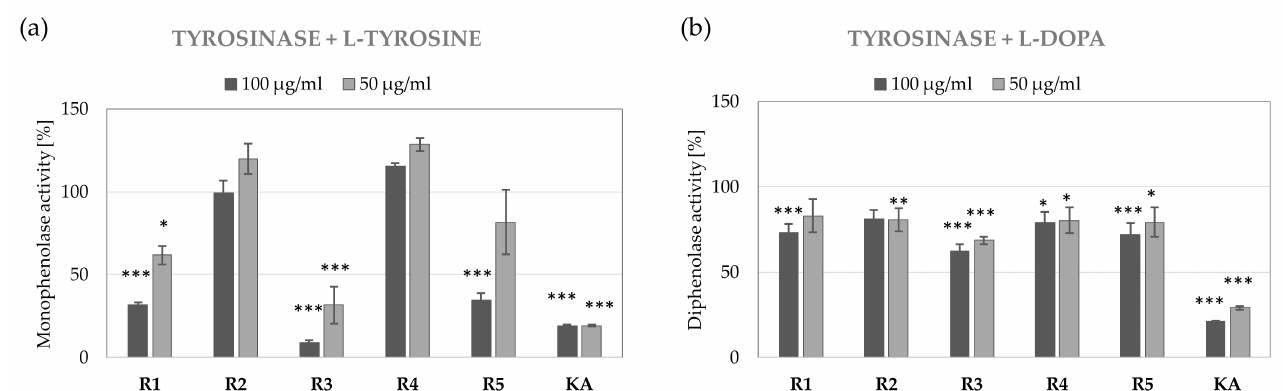
Figure 3. Inhibition of monophenolase ( a ) and diphenolase ( b ) activity of tyrosinase by R1–R5 extracts from various parts of R. platyacantha; KA- kojic acid, values on graphs represent mean ± SD ( n = 3), *** p < 0.001, ** p < 0.01, * p < 0.05.